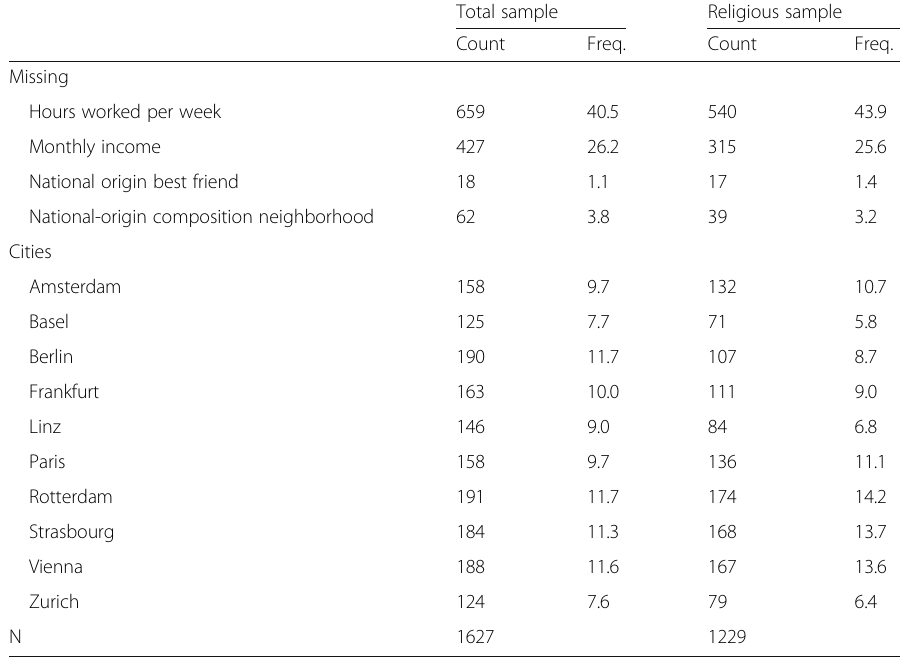
Table 9 Binary logistic regression: Interplay between social identifications, country contexts and local voting probability